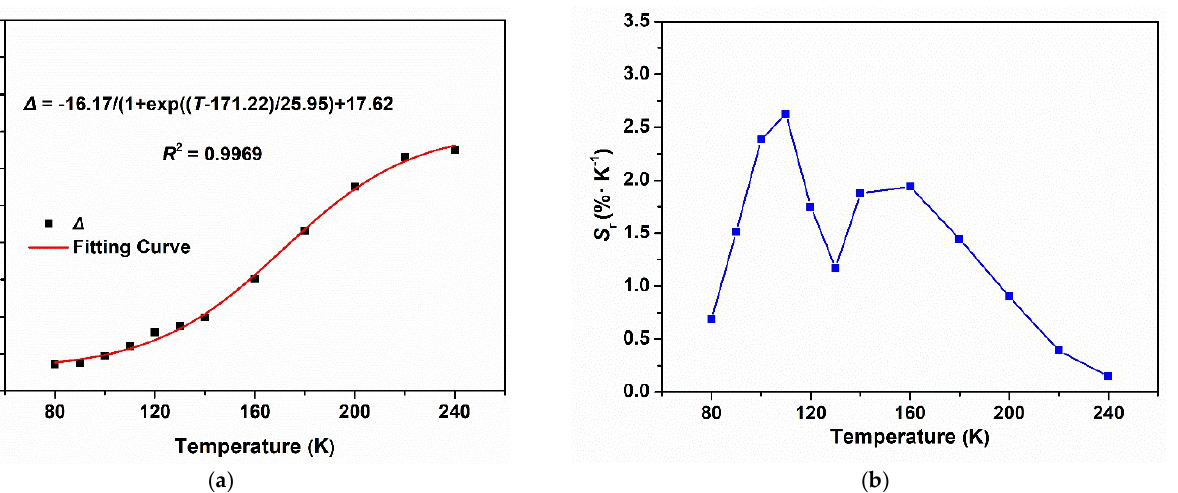
Figure 4. ( a ) Temperature-dependent emission intensity ratio ∆ ( I 493 / I 410 ) and the fitted curve of SNNU-63 in the range of 80–240 K; ( b ) temperature-dependent generalized relative sensitivity (S r ) of